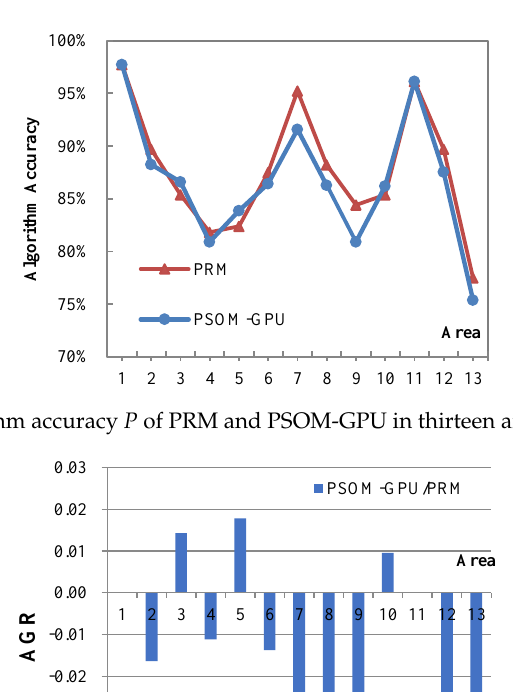
Figure 6. Time consumption of similarity computation in Area 10, Area 11, Area 12, and Area 14 under different combinations of FN and TN .